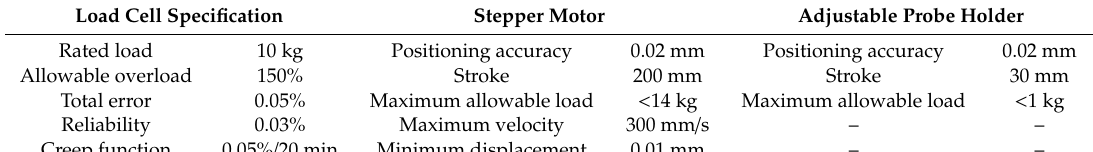
Table 1. Specification of each component in the proposed measurement platform.